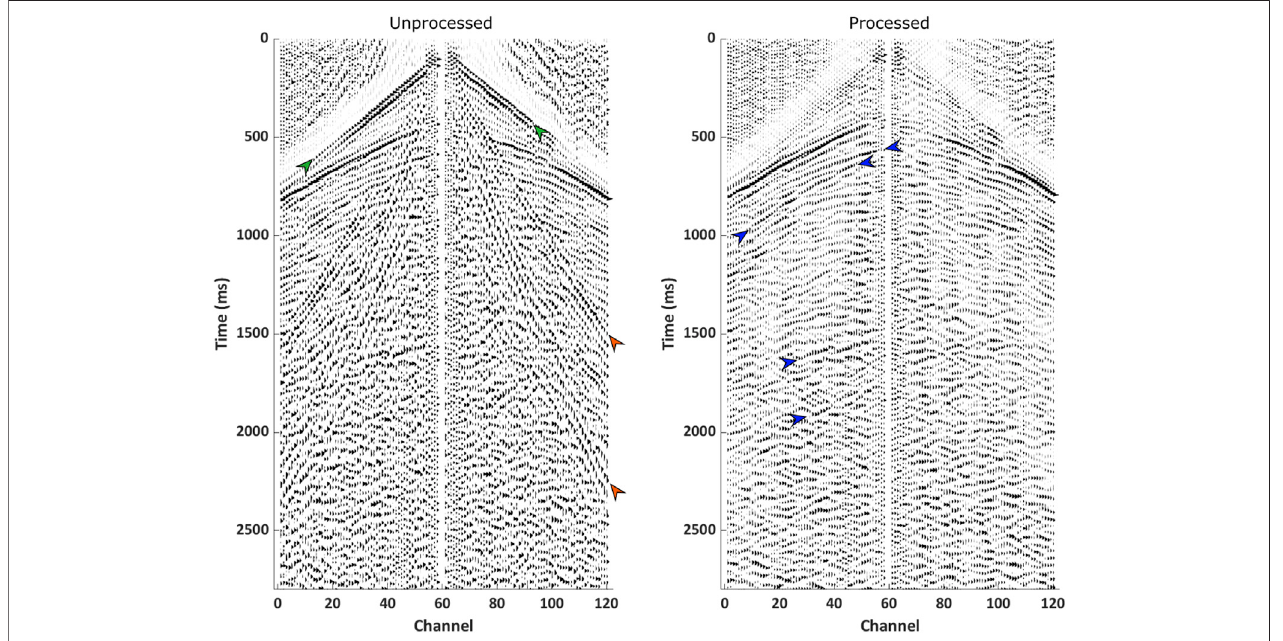
FIGURE 5 | Example shot gather from pro fi le P1 (RT-376) before and after prestack processing fl ow. Green and orange arrows indicate fi rst break and ground roll signals, respectively, that were removed. Blue arrows highlight enhanced re fl ection signals.